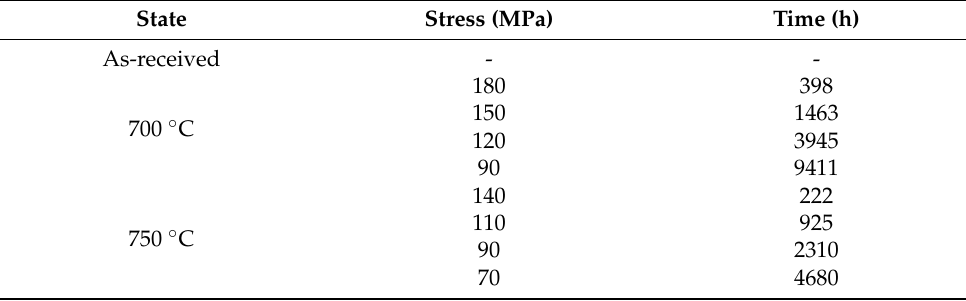
Table 2. Creep test conditions and time till